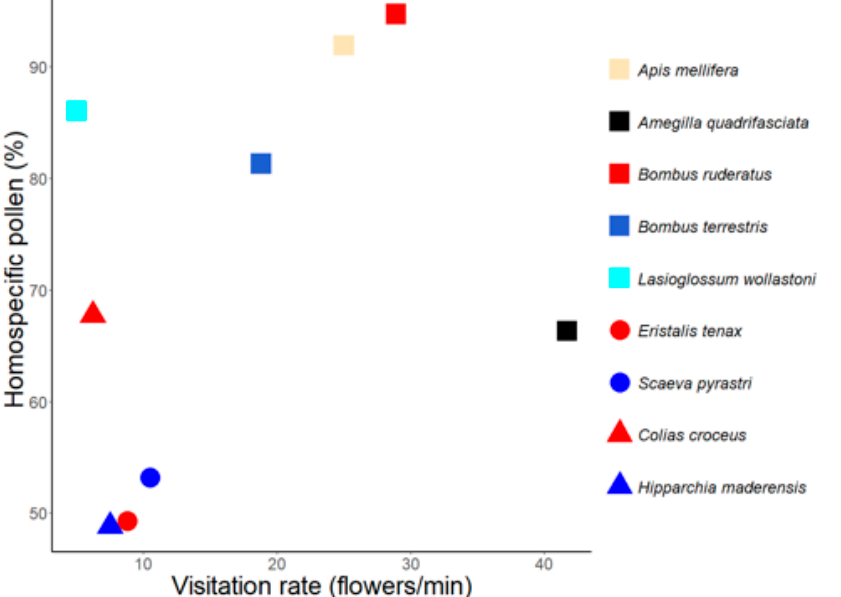
Figure 4. Average visitation rate and percentage of homospecific pollen found on the most common flower visitors of E. candicans . Visitors belong to three animal groups: bees (squares), hoverflies (circles), and butterflies